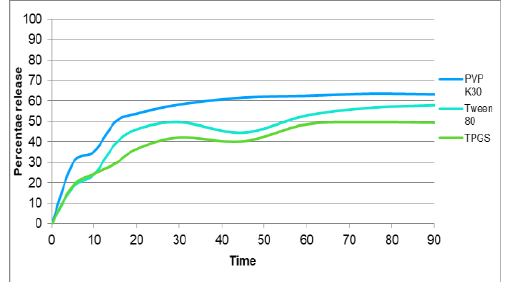
Figure 2. Influence of stabilizer type on release profile of nanosuspension in 0.1N HCl and 37  C